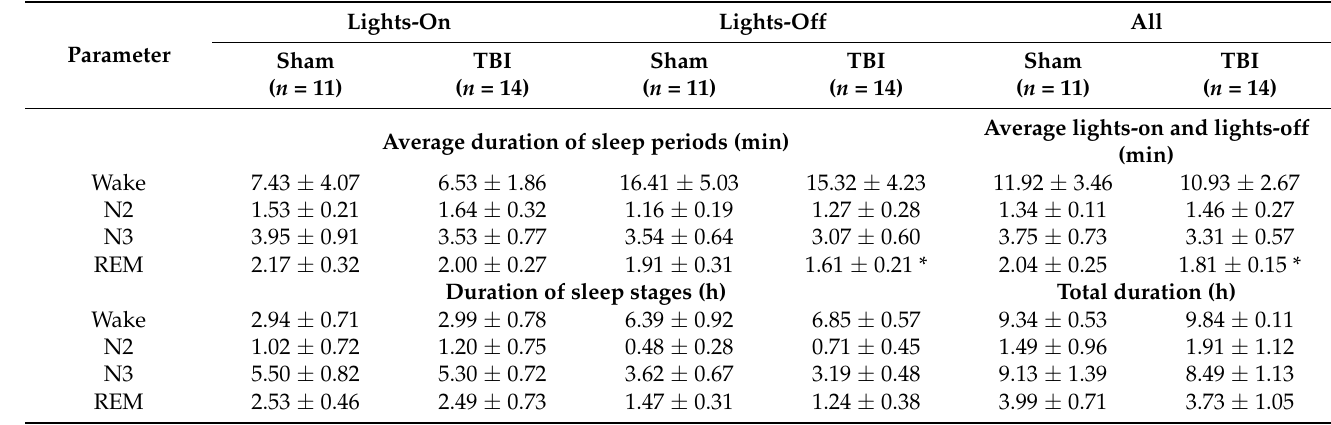
Table 3. Duration of different sleep–awake stages in sham-operated experimental controls and in rats with traumatic brain injury (TBI) during the lights-on and lights-off periods. A 24-h sleep EEG epoch was recorded in the 7th post-TBI